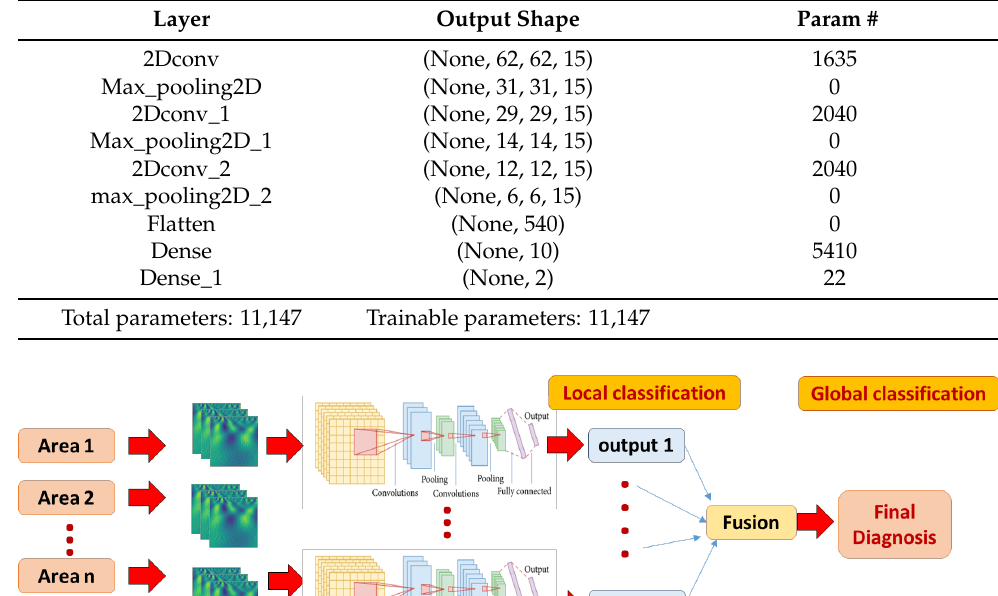
Table 1. CNN network summary.